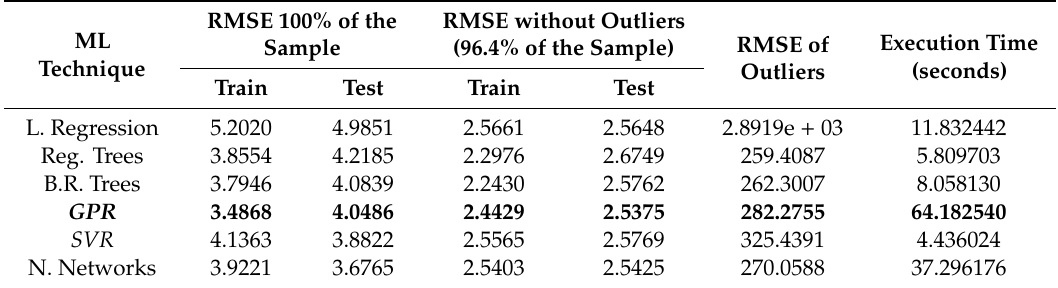
Table 11. BMI-CTDI VOL results for women’s Thorax protocol.